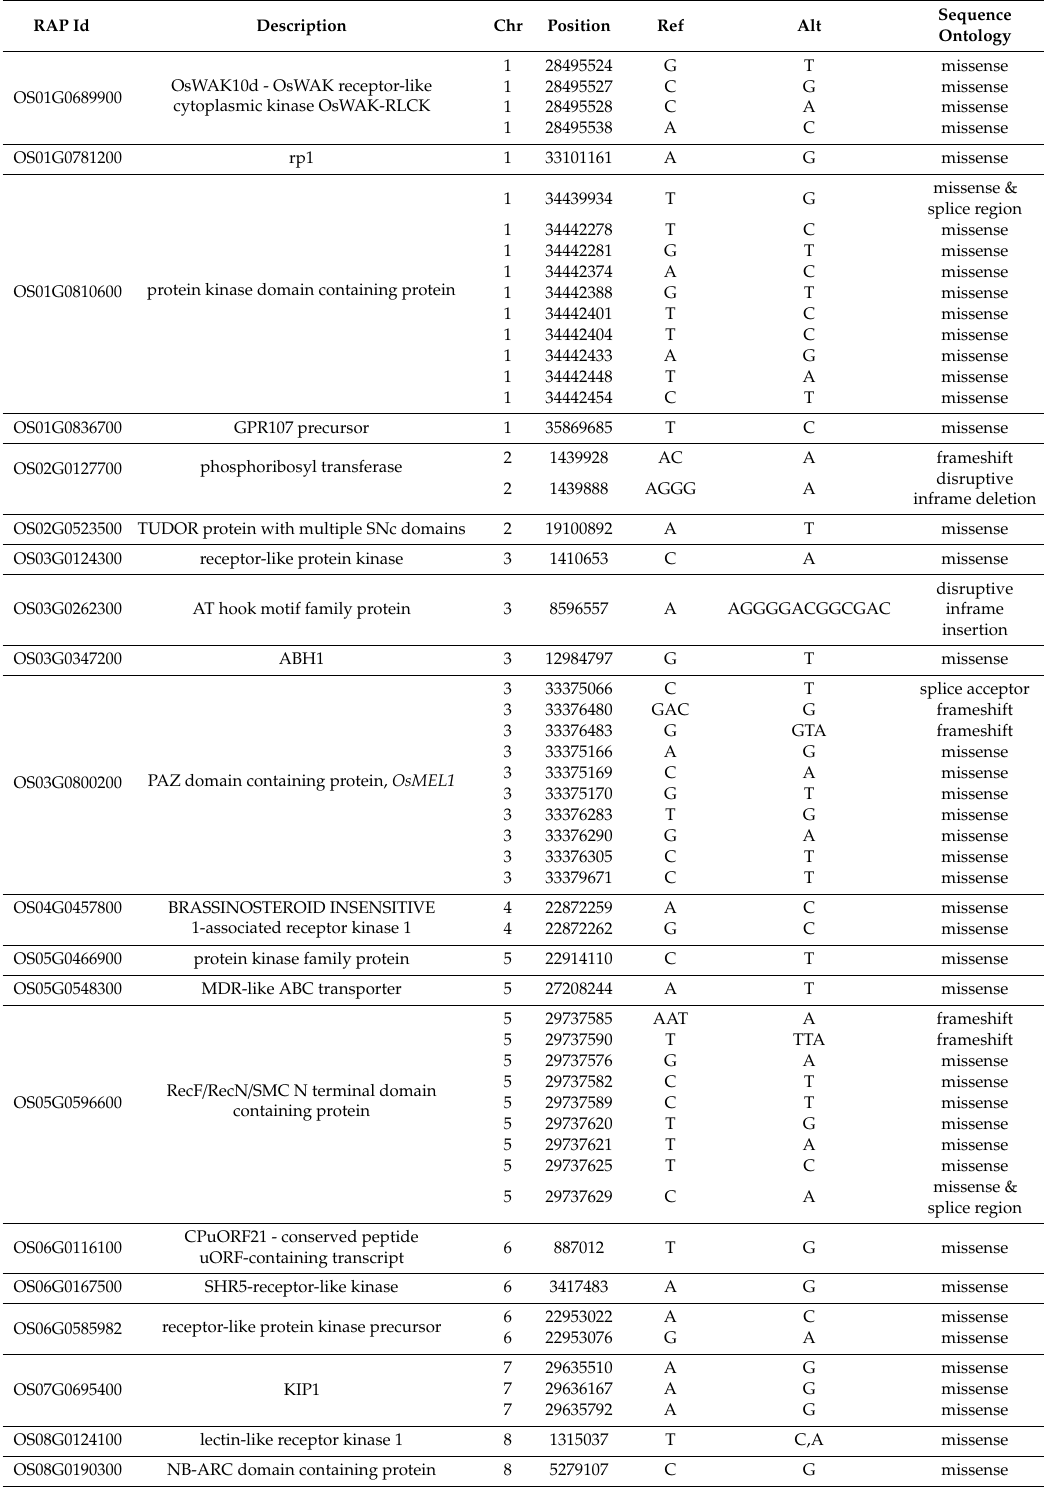
Table 3. List of the top 10 highest-expressing genes in any one of the reproductive